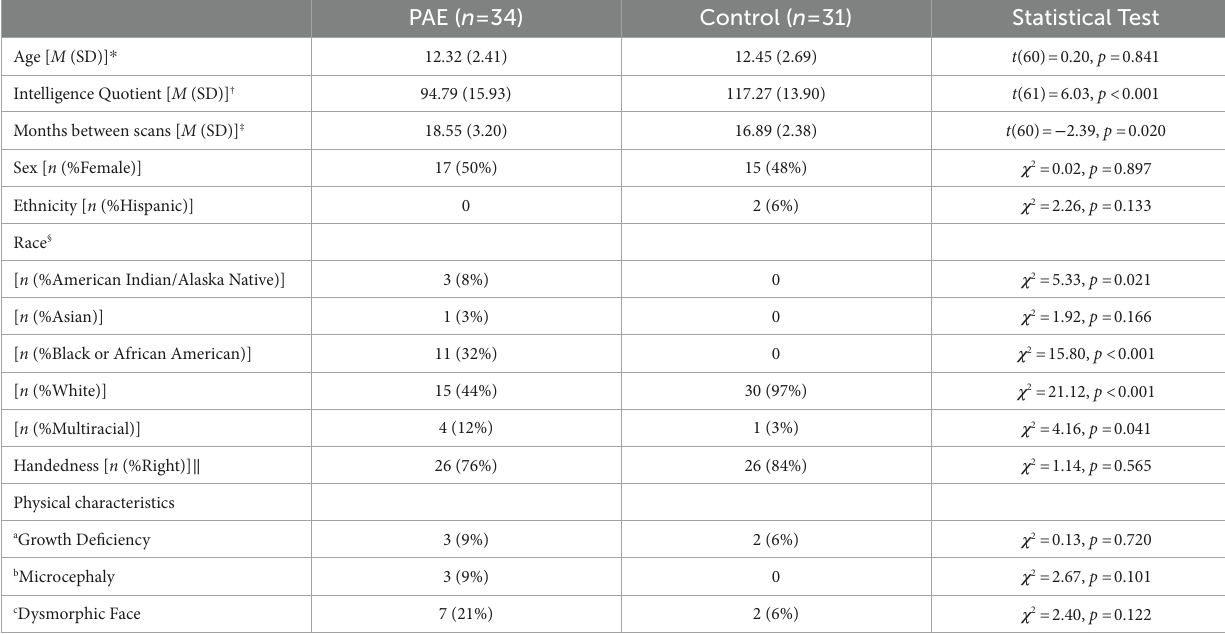
TABLE 1 Demographic characteristics of participants included in primary analyses.